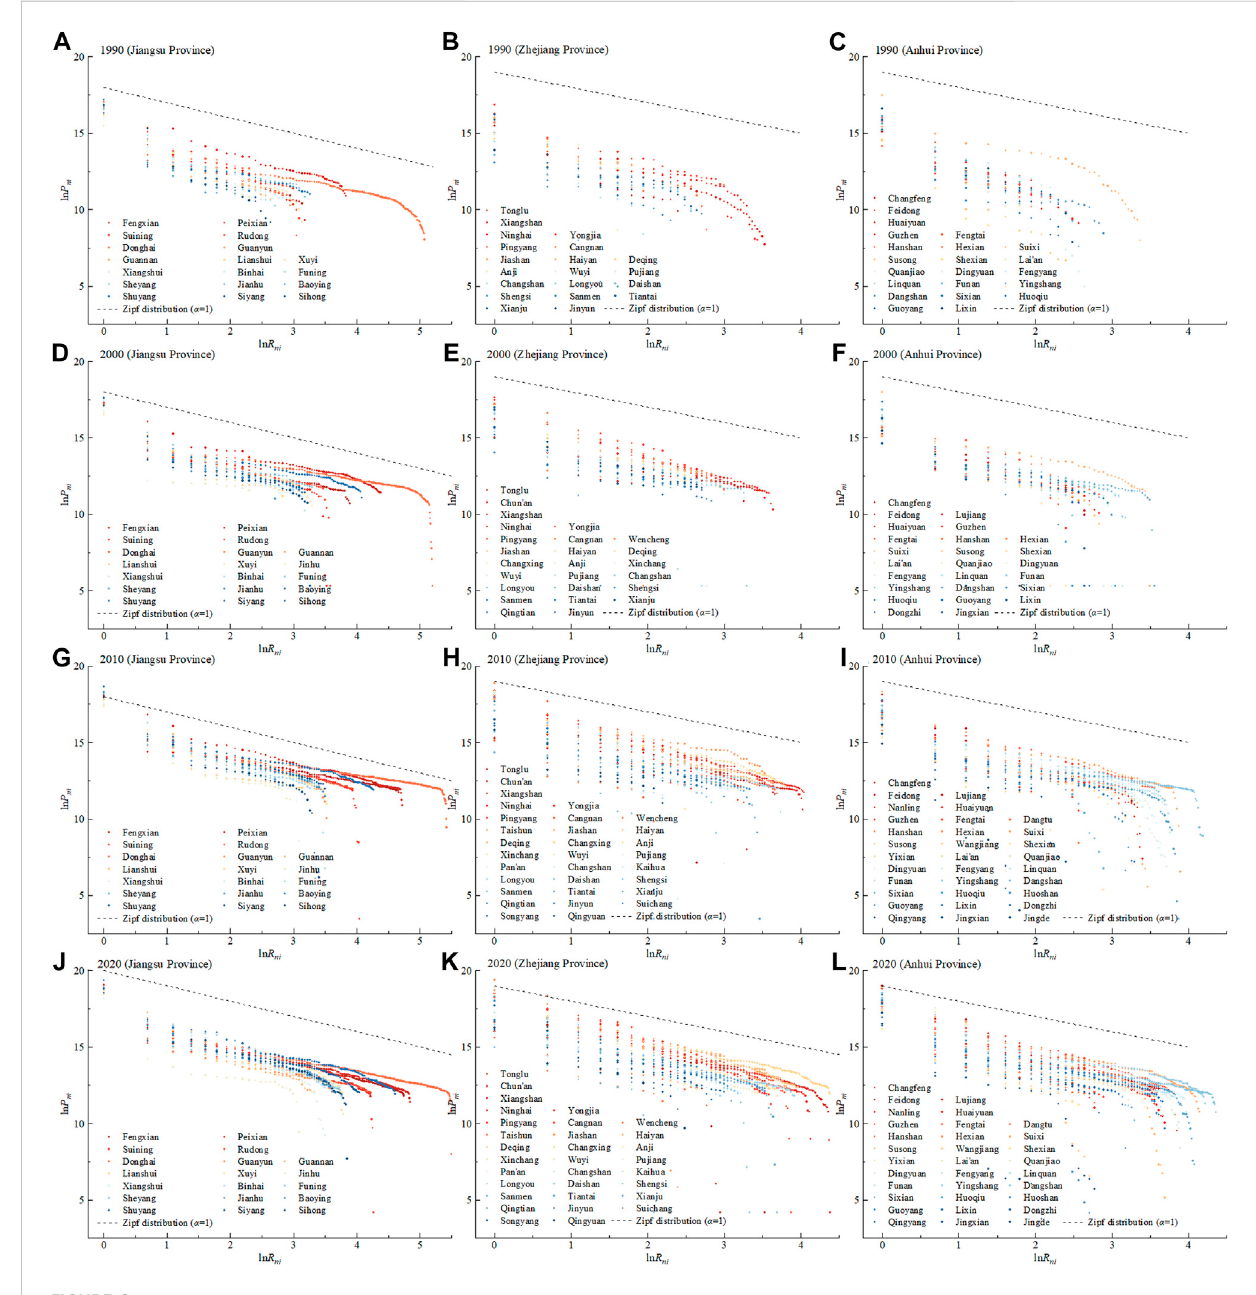
FIGURE 6 Intra city-size distribution of YRDR